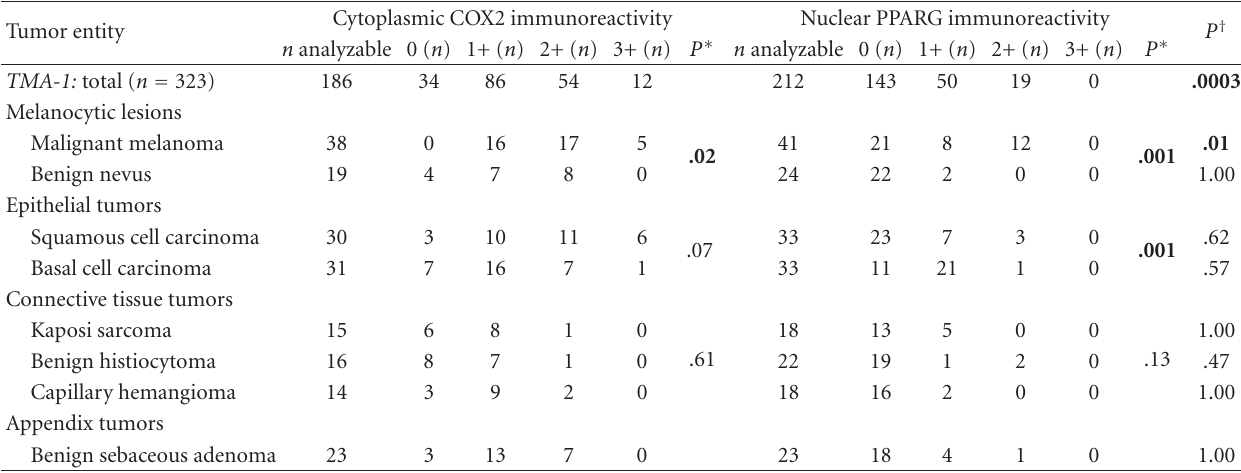
Table 1: COX2 and PPARG expression analysis of skin tumors using TMA-1.